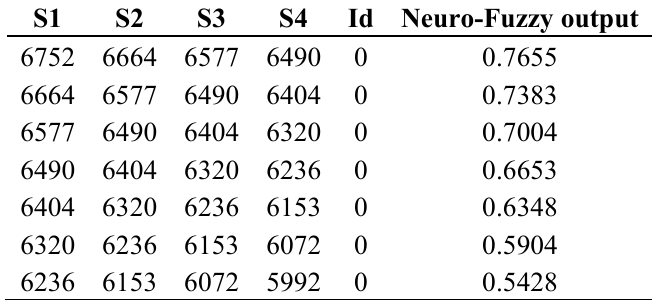
Table 4. Outputs of the Neuro-Fuzzy system for test patterns in the case, where a corner shape environment feature is being detected in a new